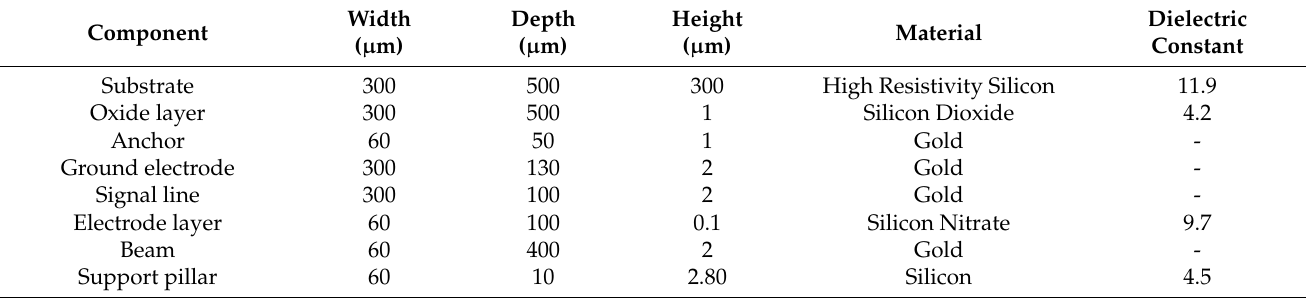
Table 1. Dimensions of the proposed